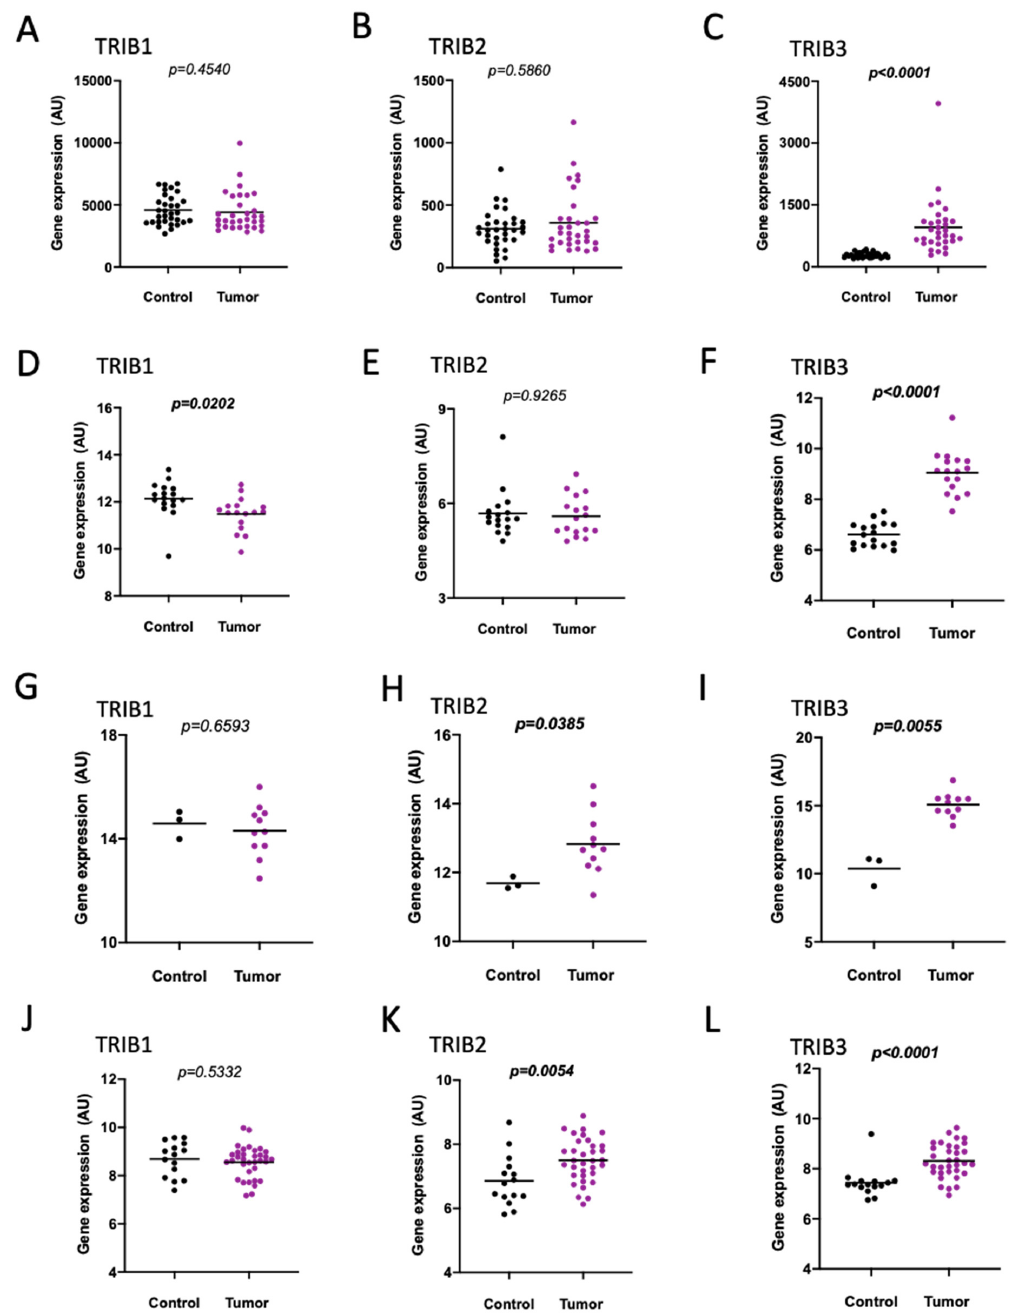
Figure 1. TRIB1 , TRIB2 , and TRIB3 gene expression in colorectal tumors compared to controls. ( A – C ): Colorectal adenomas (pedunculated colorectal polyps) (Tumor, n = 32) compared to paired normal mucosa, i.e., normal colon from the same individual (Control, n = 32) (GDS2947). ( D – F ): CRC overt tumors, from patients with different gender and ages, in different stages (Tumor, n = 17) compared to paired adjacent non-cancerous tissues (Control, n = 17). (GDS4382). ( G – I ): Primary CRC tumors from male patients diagnosed at an advanced age (69 to 87 years; late onset) (Tumor, n = 11) compared to normal controls, i.e., normal colonic mucosa samples (Control, n = 3) (GDS5232). ( J – L ): Normal colonic mucosa (Control, n = 15) compared to colorectal adenocarcinomas (both hereditary and sporadic) with microsatellite instability (Tumor, n = 34) (GDS4515). Independent datasets were analyzed, and samples plotted individually. TRIB1 (( A , D , J )—202241_at; ( G )—150749), TRIB2 (( B , E , K )—202478_at; ( H )—188922) and TRIB3 (( C , F , L )—218145_at; ( I )—113737) gene expression is represented as arbitrary units (AU). Wilcoxon paired test ( A – E ), paired two-tailed t test ( I ), unpaired two-tailed t test ( G , H ), t test with Welch’s correction ( F ), or Mann–Whitney U test ( J – L ) was performed, and the p value is represented for each graph. The horizontal bars represent the mean of the values in each